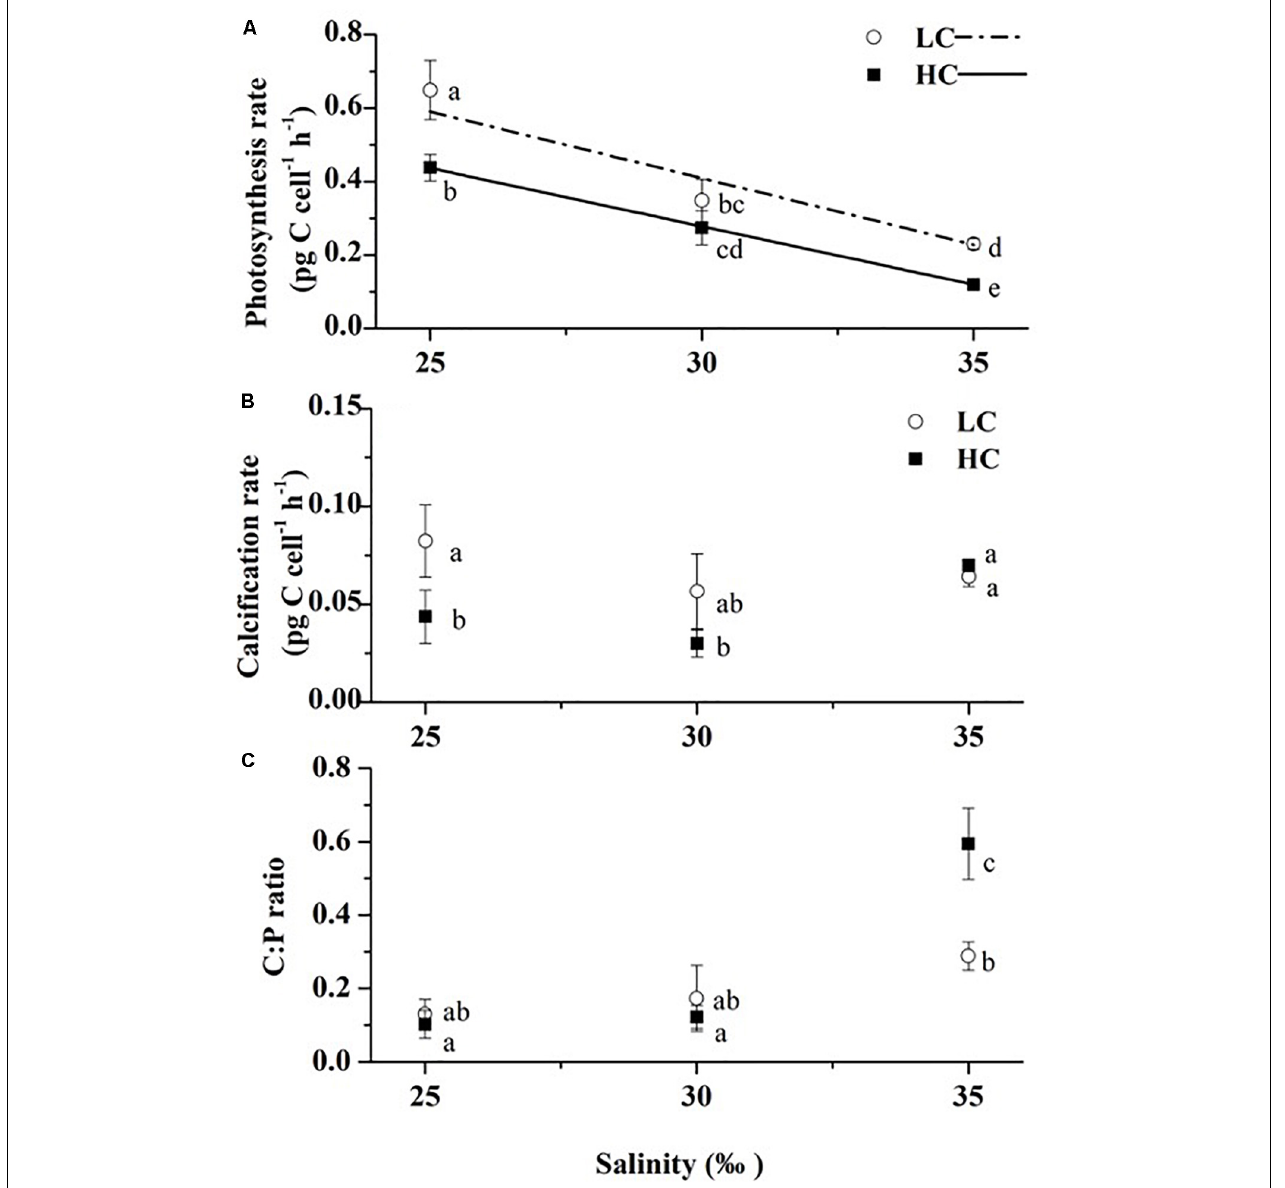
FIGURE 4 | Photosynthetic rates (A) , calcification rates (B) at 6 h after the onset of light and calcification to photosynthesis ratio, C: P (C) of three salinities (LC, open circles; HC, solid squares). The dash-dotted line and solid line are the linear regression results of the photosynthetic rates under LC and HC,